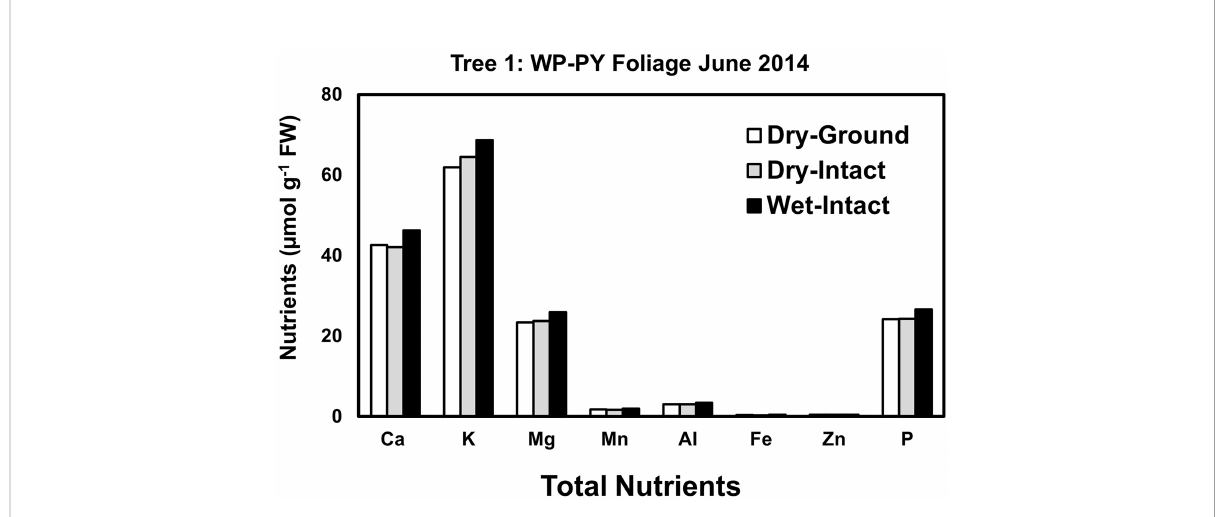
FIGURE 6 Comparison of three different tissue preparation methods for extraction of total inorganic nutrients from PY foliage of white pine. Samples were collected from a single tree in June 2014. White pine PY foliage was not available after June 2014 due to defoliation caused by a region-wide infestation of needle cast